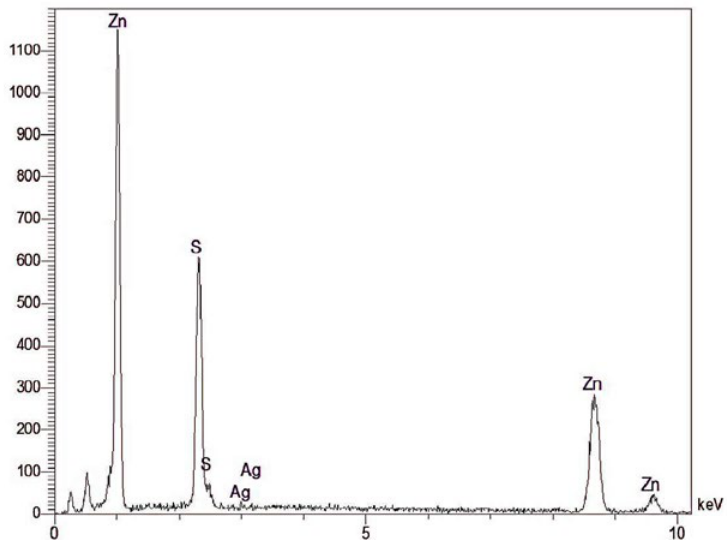
Fig. 2. The EDX spectrum of Ag-doped